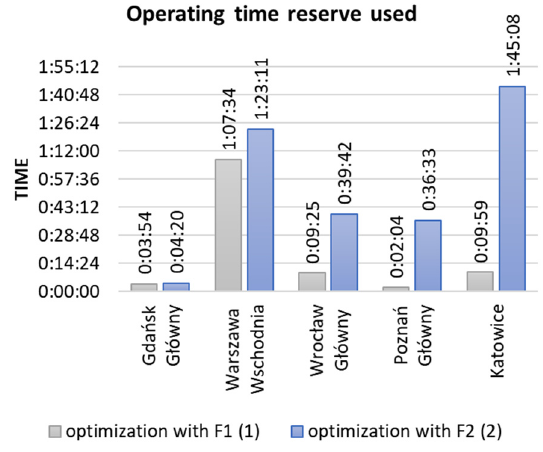
Figure 5. Operating time reserve used for F 1 (1) and F 2 (2). Source: own study.